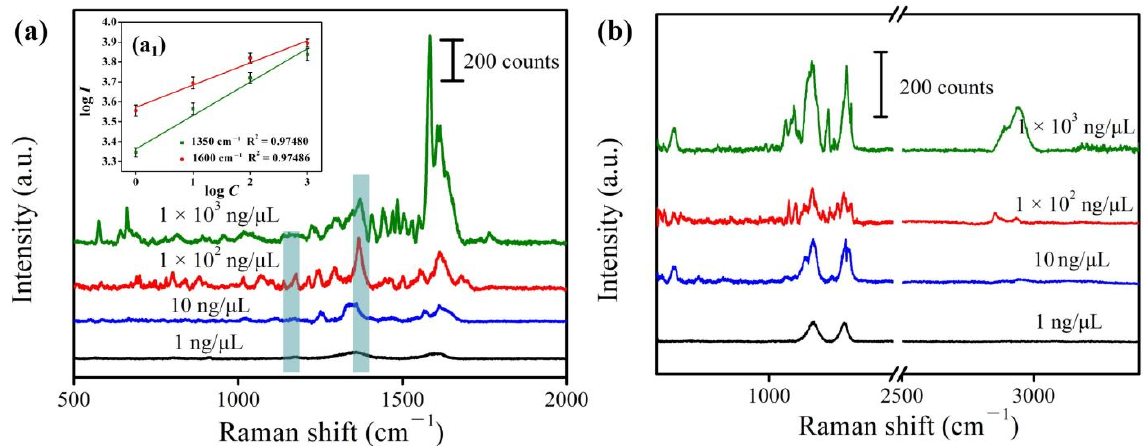
Figure 11. ( a ) Raman spectra of sodium valproate with different concentrations; ( a 1 ) the linear modified relationship curves of Raman signal intensity to sodium valproate concentration at 1350 cm −1 and 1600 cm −1 ; ( b ) Raman spectra of levetiracetam with different concentrations.